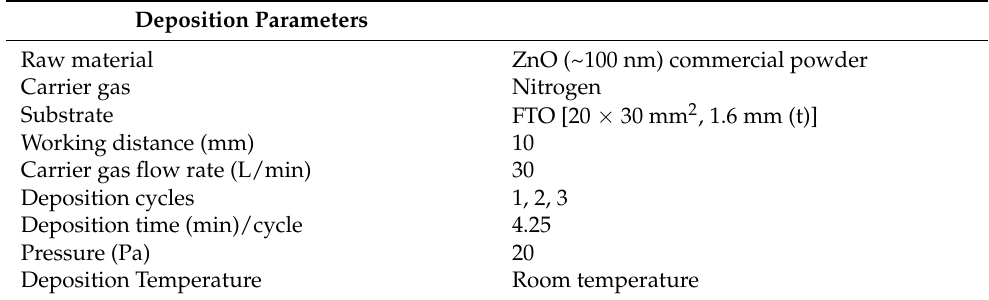
Figure 1. Schematic and photograph showing the geometry of the nozzle used for the aerosol deposition. Table 2. Deposition parameters used for the ZnO films during AD